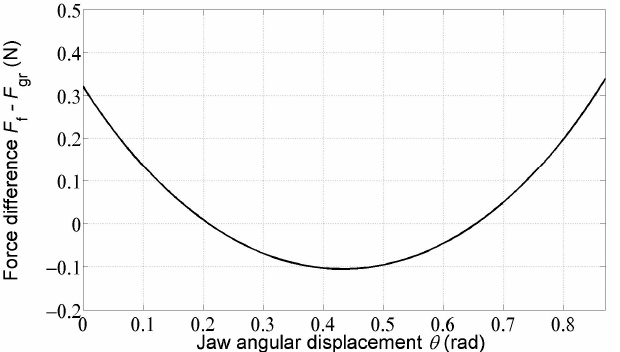
− on the jaw angular displacement θ .